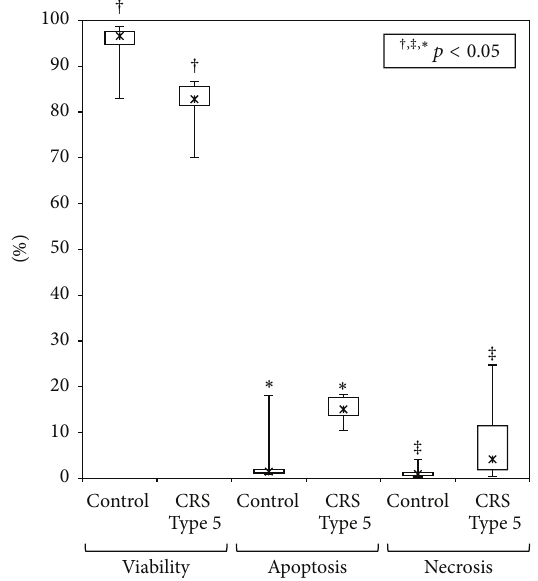
Figure 1: Evaluation of percentage of viability, necrosis, and apopto- sis in RTCs after incubation with plasma from CRS Type 5 patients and healthy